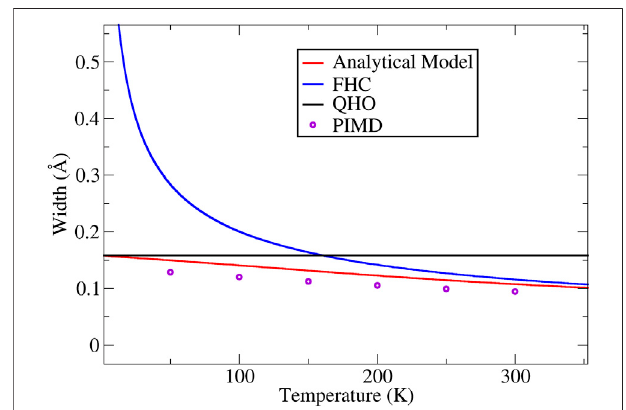
FIGURE 1 | The width of the ring-polymer predicted by Eq. 15 at different temperatures (calculated using = 670 cm − 1 ), plotted along the side withthe FHC and QHOwidths. The PIMD simulation results are also plotted in the fi gure using open